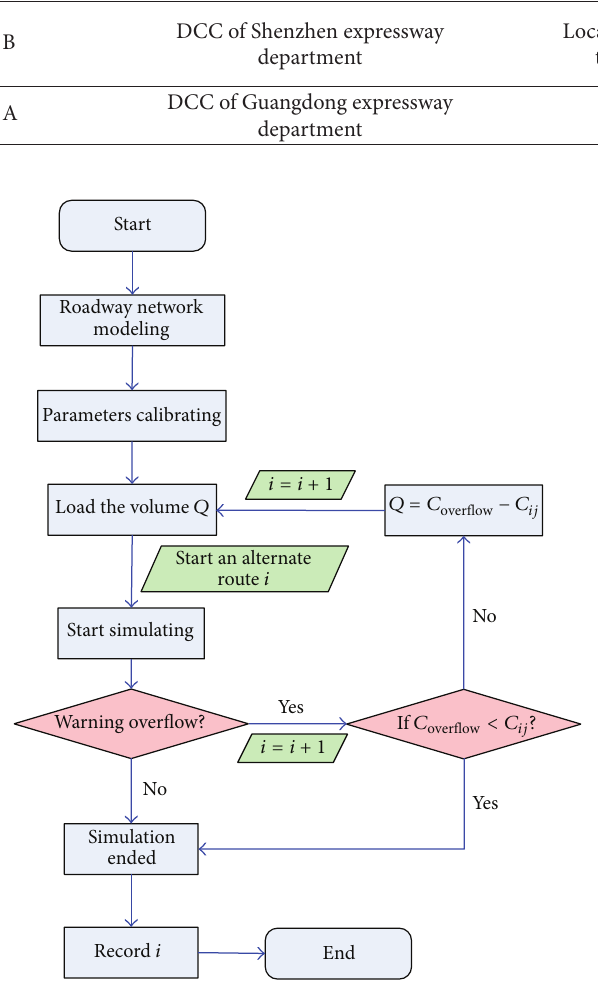
Figure 5: Flow chart for the operation process of CORSIM simula- tion for fixed 𝑗 and 𝑄 to confirm an alternate route